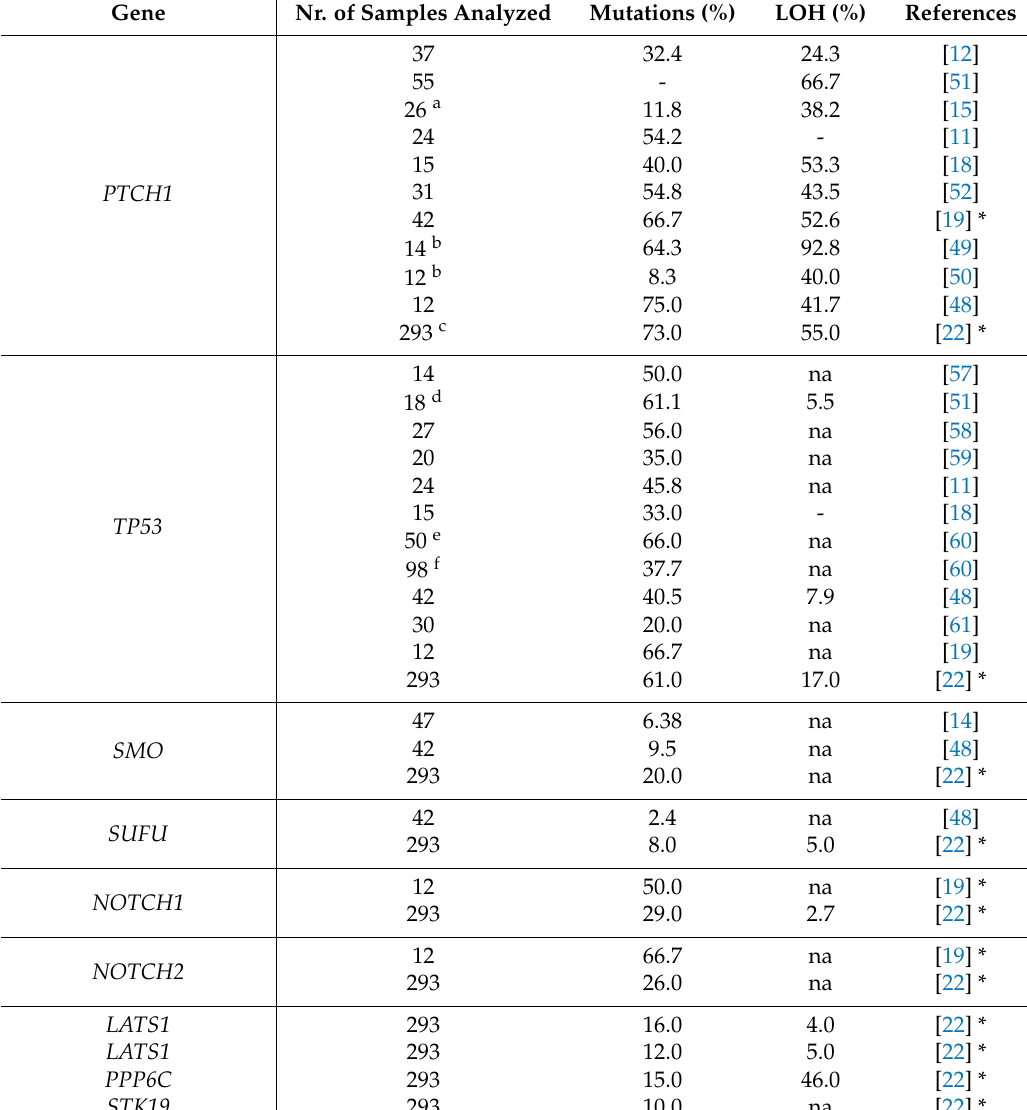
Table 1. Frequency of mutations and loss of heterozygosity (LOH) in cancer-related genes across published studies in basal cell carcinoma